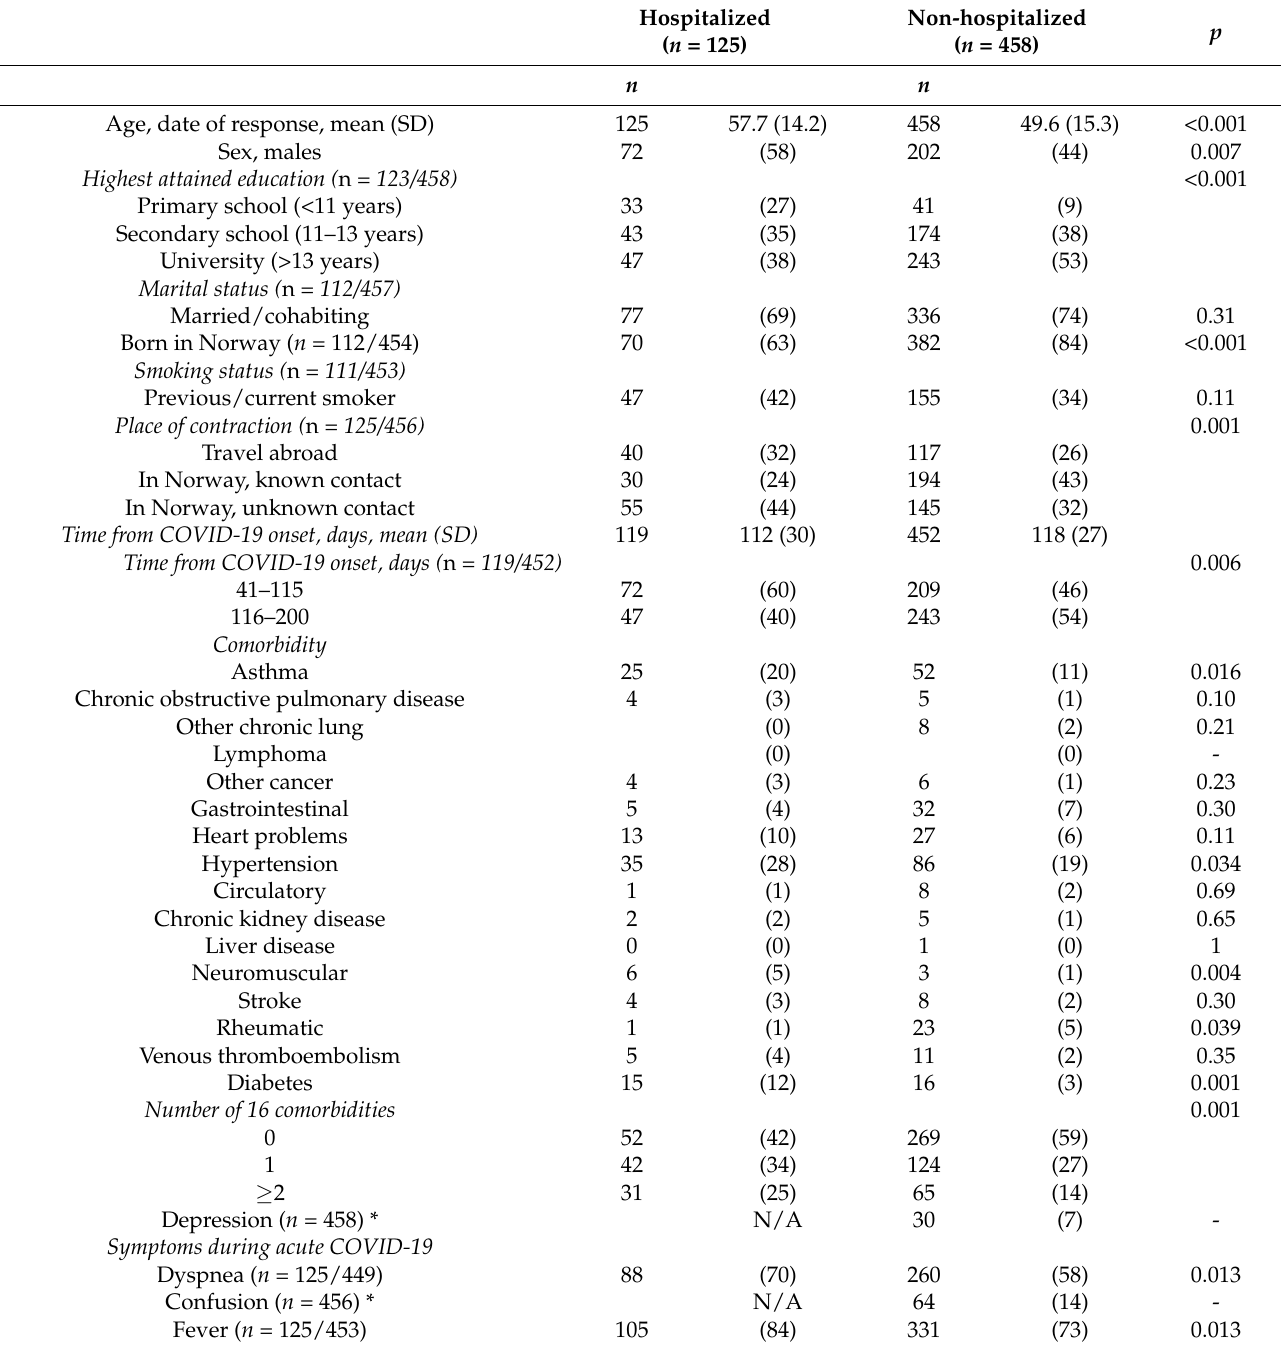
Table 1. Descriptive statistics for respondents in the two cohorts ( n = 583), number (%) unless otherwise